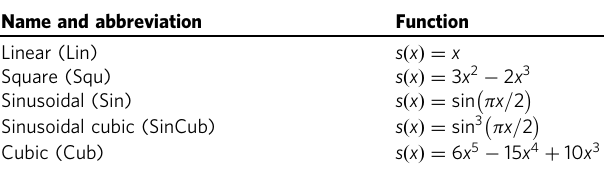
Table 1 Scheduling functions s ( x ) ( x = m / M ) tested in Eq. 1.